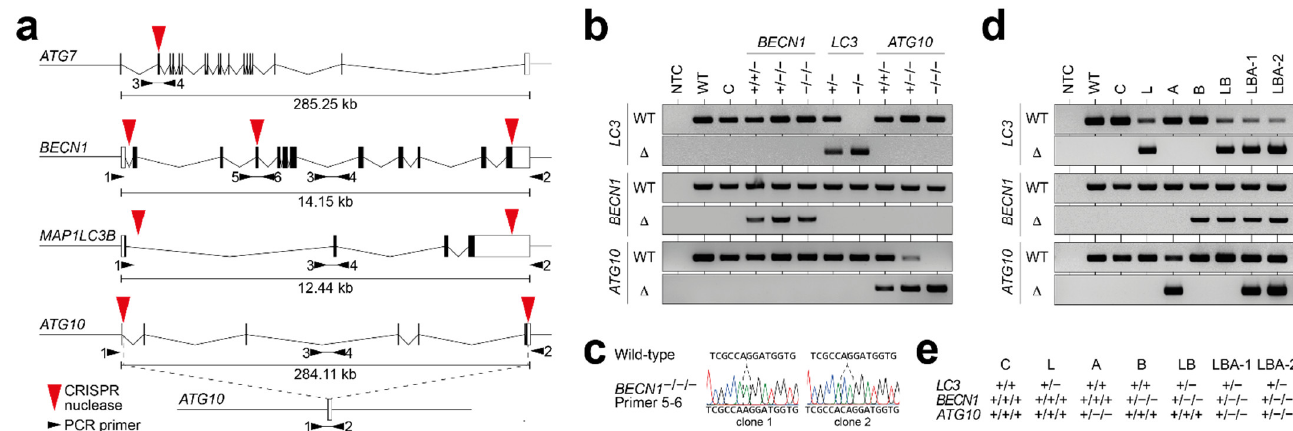
Figure 1. Generation of NSCLC (H460) cells with CRISPR-engineered autophagy gene deletions. ( a ) Genomic structure of the targeted ATGs. Red triangles mark sgRNA target sites, and black arrows denote primers used for PCR validation of deletions. Primer pair 1–2 was designed to yield a product only if the intervening sequence between two sgRNA target sites has been deleted (as illustrated for ATG10 as an example), whereas primer pair 3–4 amplifies the nondeleted alleles. ( b ) PCR validation of clones with deletions of single ATGs. ∆ , deleted allele (primer pair 1–2); WT, nondeleted allele (primer pair 3–4). ( c ) Sequencing of BECN1 fs/−/− reveals frameshift mutations in the nondeleted BECN1 allele. ( d ) PCR validation of clones with deletions in multiple ATGs. ( e ) Simplified nomenclature of clones with deletions in multiple ATGs. NTC, no template control; C, control clone transfected with nontargeting nuclease; and WT, wild-type H460.